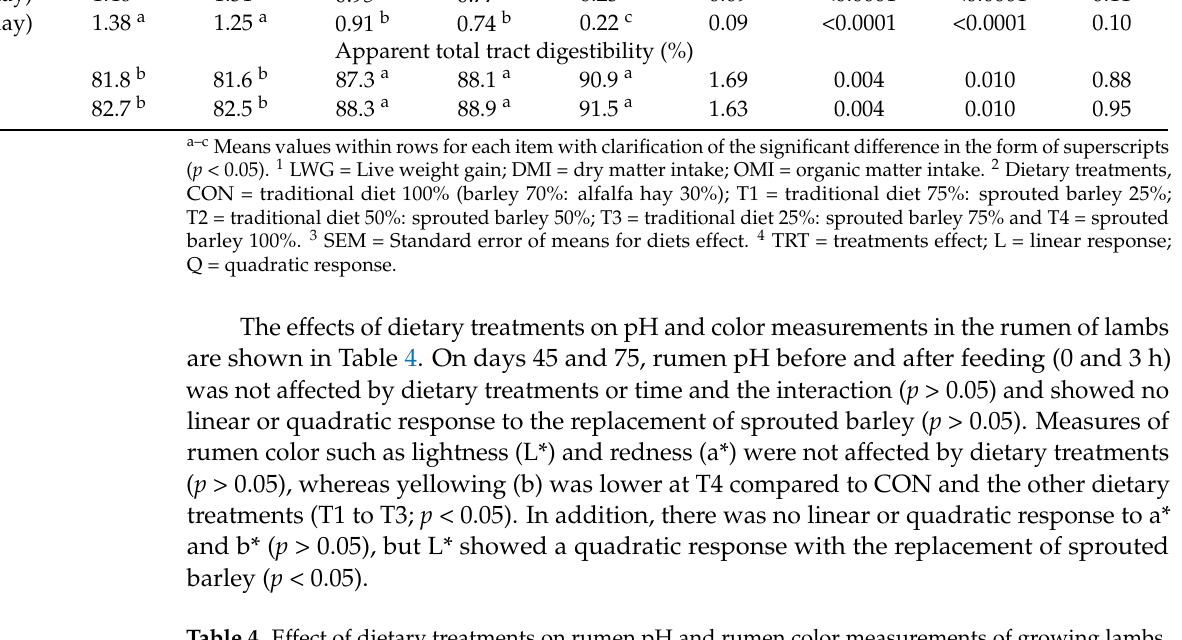
Table 4. Effect of dietary treatments on rumen pH and rumen color measurements of growing lambs. Dietary Treatments (TRT) 2 p -Value